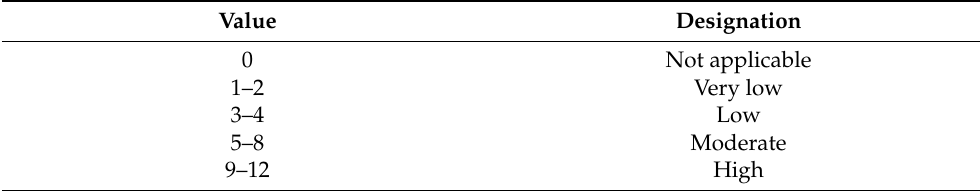
Table 1. Variables considered for the determination of groundwater dependent ecosystems in RH9, data source and respective categorization into five classes (0—not applicable; 1—very low; 2—low; 3—moderate; 4—high). All the variables correspond to GIS layers, the one associated to Wetland/Lakes being derived from satellite imagery, as described in the original source. Variables Description/Source Classes 0: 0 springs/100 m 2 Spring density RBMP—Azores [9]. 4: (0.15–0.20 springs/100 m 2 ) Classes 411 (wetlands) and 512 (lakes) from the satellite Azores 0: 0 m 2 /100 m 2 land use map [42]; the lake located inside the so-called Wetland/Lakes Furna do Enxofre volcanic cave (Graciosa Island) was added according to the mapping by [43] Base flow was estimated through the application of the software BFI+ v.s 3.0 [44] on the average daily flow data recorded in the Baseflow various hydrometric stations that make up the Hydrometeorological Network of the Azores